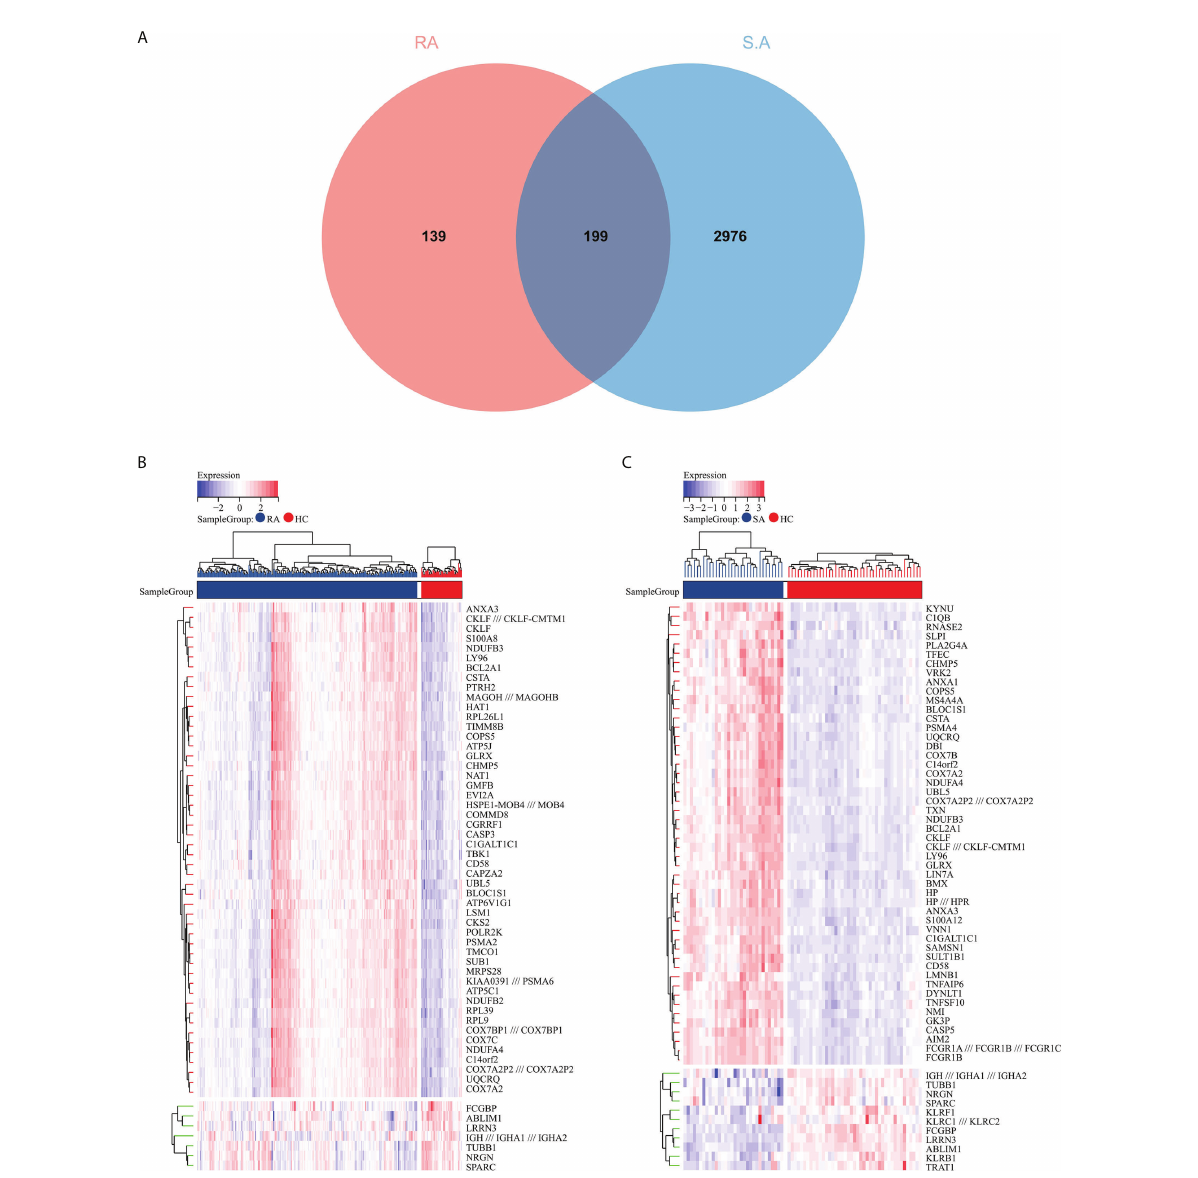
FIGURE 4 Common DEG screening. (A) Venn diagram on GSE93272 DEGs and GSE33341 DEGs. (B) Clustered heat map of common DEGs belonging to the RA group. (C) Clustered heat map of common DEGs in the SA group, with the RA/SA group colored blue and the HC group colored red. Red rectangles indicate elevated genes (P < 0.05), whereas blue rectangles indicate downregulated genes (P <